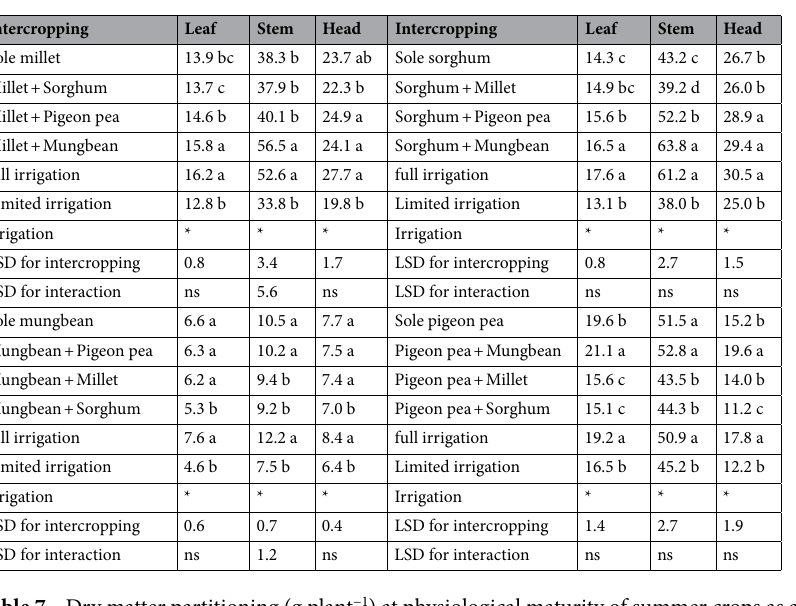
bean and pigeonpea at anthesis were significantly affected by irrigation and intercropping and are presented in Table 5. Under full irrigated condition, all crops produced higher SDW plant −1 at anthesis than limited irrigated while lowest SDW plant −1 for both cereals was recorded when intercropped with each other (Fig. 4B,C), respec- tively. Pigeon pea intercropped with mungbean or sown as sole crop produced higher SDW plant −1 at anthesis (Fig. 4D) than when intercropped with millet and sorghum. The planned mean comparison indicated that cere- als intercropped with legumes produced maximum SDW plant −1 at anthesis than intercropped with cereals (Table 6E,F). In contrast, legumes intercropped with legumes produced higher SDW plant −1 at anthesis than legumes intercropped with cereals (Table 6G,H). Moreover, millet and/or sorghum intercropped with mungbean produced higher SDW plant −1 at anthesis than intercropped with pigeon pea. Head/pods dry weight (g plant −1 ) at anthesis. Head/pods dry weight (g plant −1 ) of millet, sorghum, mungbean and pigeon at anthesis are shown in Table 5 and this parameter was significantly affected by irrigation and intercropping. All crops grown under full irrigated condition produced higher H/PDW plant −1 at anthesis than limited irrigated condition. Both cereals, millet and sorghum intercropped with mungbean or with pigeon pea had produced maximum H/PDW plant −1 at anthesis than intercropped with each other (Table 6I,J), respec- tively. Mungbean intercropped with pigeon pea or pigeon pea intercropped with mungbean or sown as sole crop produced higher H/PDW plant −1 than intercropped with cereals (Table 6K,L). The planned mean comparison indicated that cereals intercropped with legumes produced higher H/PDW plant −1 at anthesis than when inter- cropped with other cereals. In contrast, legumes intercropped with legumes produced higher H/PDW plant −1 at anthesis than legumes intercropped with cereals crops (Table 6K,L). Moreover, all crops produced compara- tively higher H/PDW at anthesis in intercropping than mono-cropping, except for sole mungbean. Millet and/ or sorghum intercropped with mungbean produced high HDW at anthesis than intercropped with pigeon pea. Leaf dry weight (g plant −1 ) at physiological maturity. Data about leaves dry weight (LDW) plant −1 at PM of millet, sorghum, mungbean and pigeon are shown in Table 7. Both irrigation and intercropping were highly significantly affected LDW plant −1 at PM. All crops grown under full irrigated condition produced higher LDW plant −1 at PM than under limited irrigated condition. Both cereals, millet and sorghum intercropped with mung- bean or with pigeon pea produced maximum LDW plant −1 than intercropped with each other (Table 8A,B), respectively. Mungbean intercropped with pigeon pea or pigeon pea intercropped with mungbean or sown as sole crops produced higher LDW plant −1 than intercropped with millet and sorghum (Table 8C,D), respectively. The planned mean comparison revealed that cereals intercropped with legumes produced higher LDW than when intercropped with cereals. In contrast, legume intercropped with legume produced higher LDW than legume intercropped with cereal crops. Furthermore, both cereals produced higher LDW in intercropping than mono-cropping. In contrast, legumes produced maximum LDW in sole cropping than intercropping. Millet intercropped with mungbean produced higher LDW than when intercropped with pigeon pea under both water regimes (Fig. 4E). Similarly, pigeonpea intercropped with pearl millet produced comparatively higher LDW than intercropped with sorghum (Fig. 4F).